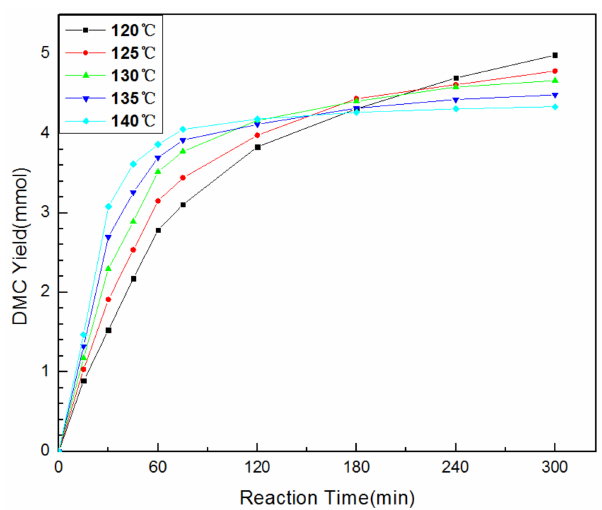
Figure 5. Effects of reaction temperature of nanowires on the catalytic performance for DMC formation.